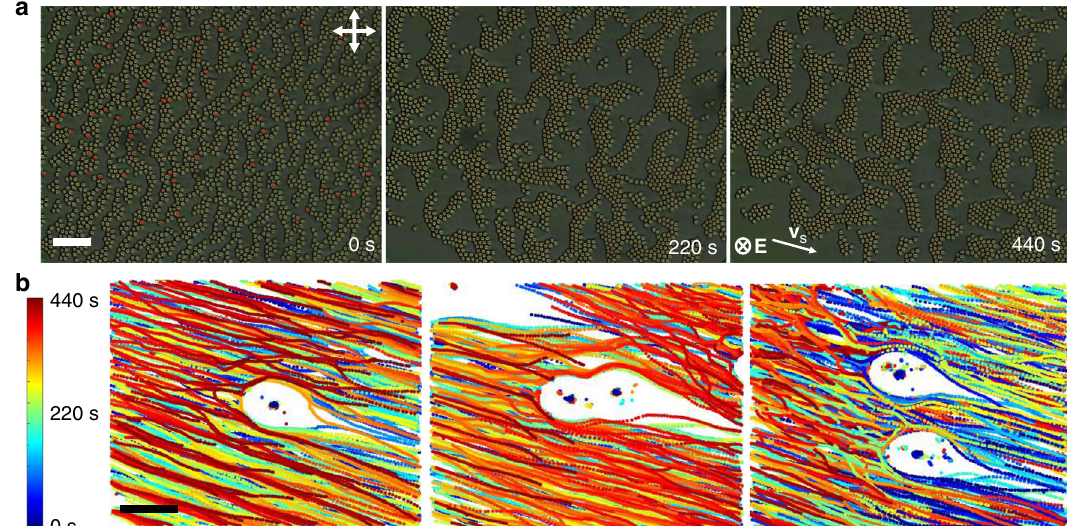
Fig. 8 Collective motion of skyrmion clusters within schools while bypassing obstacles. a Polarizing micrographs of clustered skyrmion motion taken from the Supplementary Movie 1, where some skyrmions are pinned to the substrate and act as stationary obstacles (marked with red points in the fi rst frame). The motion is powered by U = 3 V at 60 Hz. Polarizer orientations are marked with white double arrows; direction of motion and electric fi eld are marked on the last frame of a . The elapsed time is shown in the bottom-right corners of micrographs. The scale bar is 100 µ m. The chiral LC is the nematic host ZLI-2806 doped with CB-15. b Examples of trajectories of skyrmion motion avoiding pinned obstacles, color coded by the elapsed time according to the scheme shown on the left-side inset. Time-coded trajectories reveal details of skyrmions bypassing one obstacle (left), two connected obstacles (middle), and two separated obstacles (right). The scale bar is 50 µ m